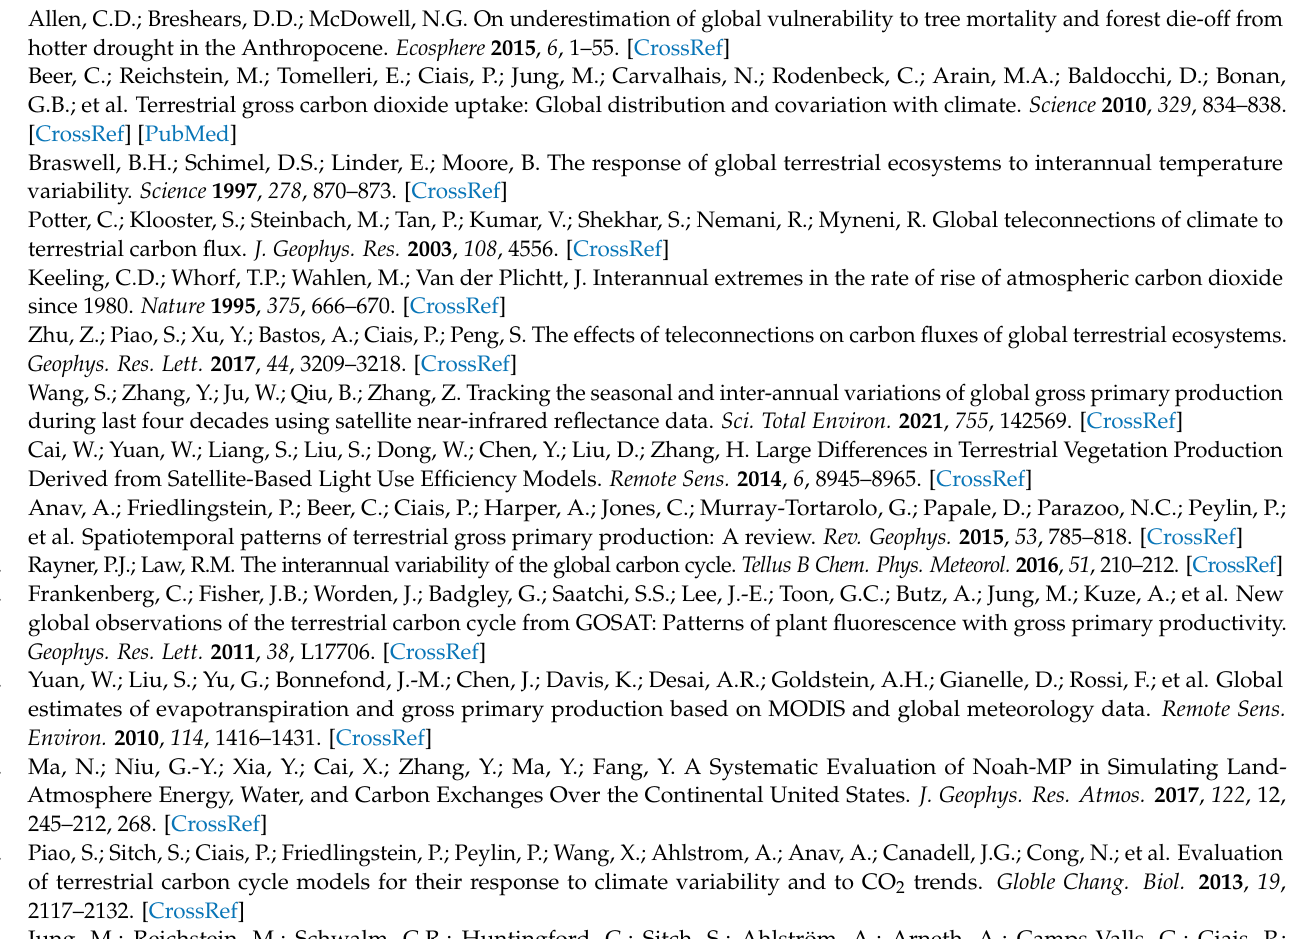
Figure A8. Relations between Pearson r and time lag. ( a ), changes in Pearson r for CCDAS-optimized soil moisture with time-lag response of continental soil moisture to two ENSO indices, MEI and Niño 3.4. ( b ), same as ( a ), but for NEP. ( c ), same as ( a ), but for GPP.